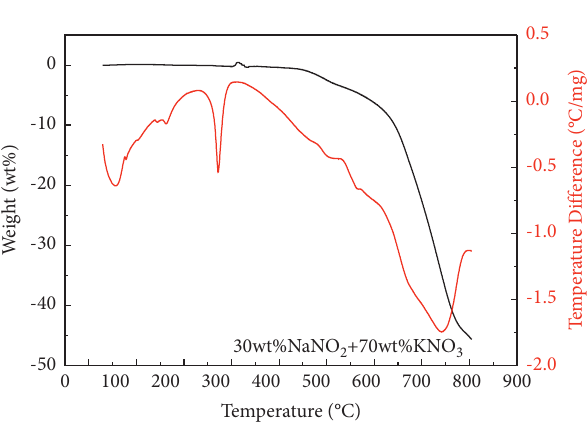
Figure 4: The DSC-TGA curves for the 30 wt%NaNO